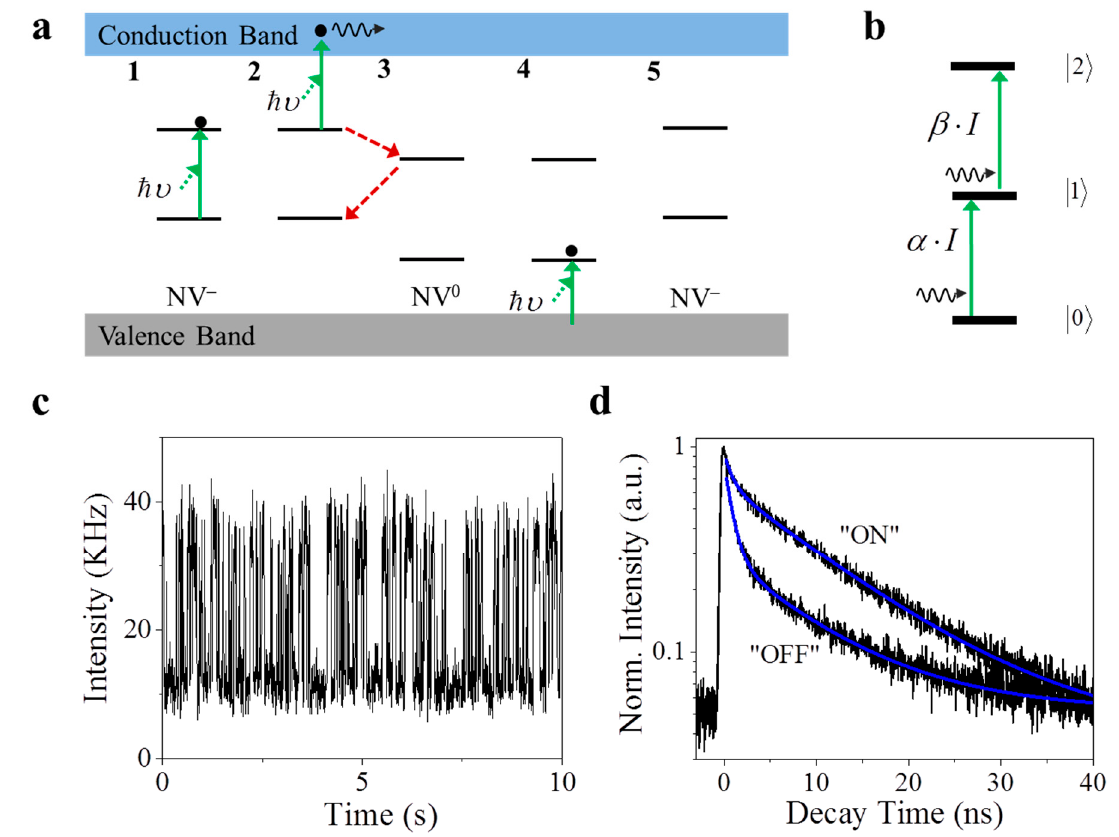
Figure 1. ( a ) Schematic diagram of the charge conversion (photonionization and recharging) process between negative nitrogen vacancy (NV − ) and neutral nitrogen vacancy (NV 0 ). Photonionization process: 1. A single NV − is excited by absorbing one photon with the energy (cid:125) υ . 2. The electron on the excited state of NV − is excited to the conduction band after absorbing a second photon subsequently. 3. The NV center ends up as the NV 0 , which functions as a dark state for NV − . Recharging process: 4. An electron in the valence band is excited to the ground state of NV 0 . 5. After obtaining one electron, the NV center ends up as the NV − . A similar diagram can be found in [15,16]. ( b ) A diagram summarizing the photonionization is a one-photon absorption process, while recharging/recombination is a sequential two-photon procedure. ( c ) The characteristic time trace of the fluorescence intensity of a single NV center under the excitation of a 532 nm laser beam, showing the fluorescence intermittency in a single NV center. ( d ) A time-correlated single photon counting histogram suggests the lifetime of each state as 11.88 ns for the “ON” state and 6.14 ns for the “OFF” state.